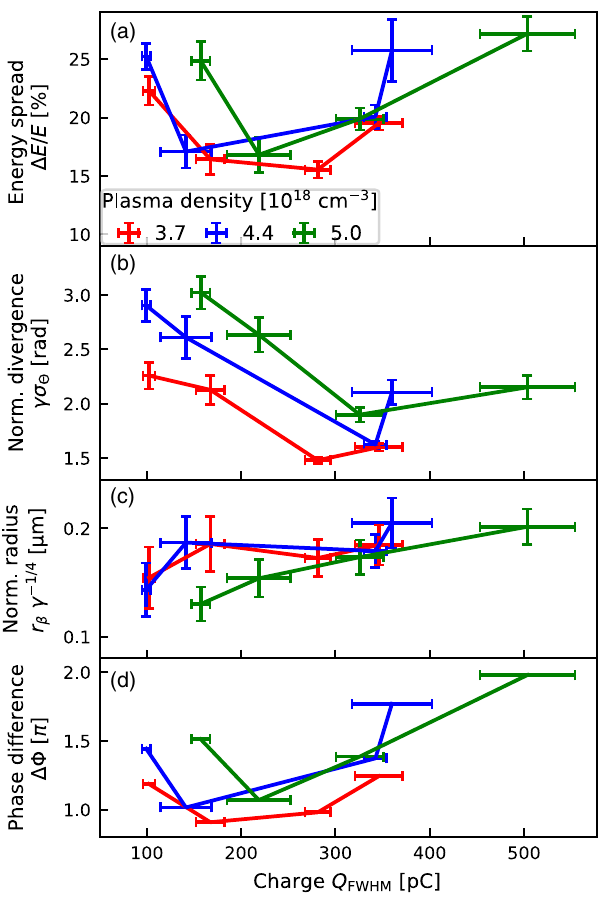
FIG. 3. Measured relative energy spread Δ E=E (a), normalized divergence γσ Θ (b), betatron radius r β γ − 1 = 4 , (c) and calculated betatron phase difference Δ ϕ according to Eq. (2) (d) obtained from electron bunches with different charges and at three different plasma densities, 3 . 7 × 10 18 cm − 3 (red line), 4 . 4 × 10 18 cm − 3 (blue line), and 5 . 0 × 10 18 cm − 3 (green line). Every data point represents the average of up to 15 shots with constant experimental parameters and the error bars denote the standard error of the mean. The error bars in (c) include the systematic error obtained from sensitivity analysis [14]. The maximum beam energy ranges from 300 MeV to 450